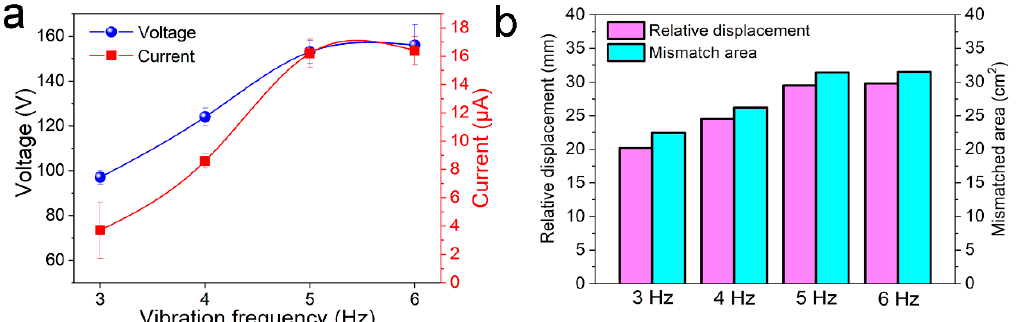
Figure 8. ( a ) Output voltage and current statistical results for the CS-TENGs operated vertically at a vibration frequency of 3–6 Hz. ( b ) Simulation results for the maximum relative displacement and the mismatched area between the inner cylinder and the outer tube for the CS-TENGs operated vertically at vibration frequency of 3–6 Hz.